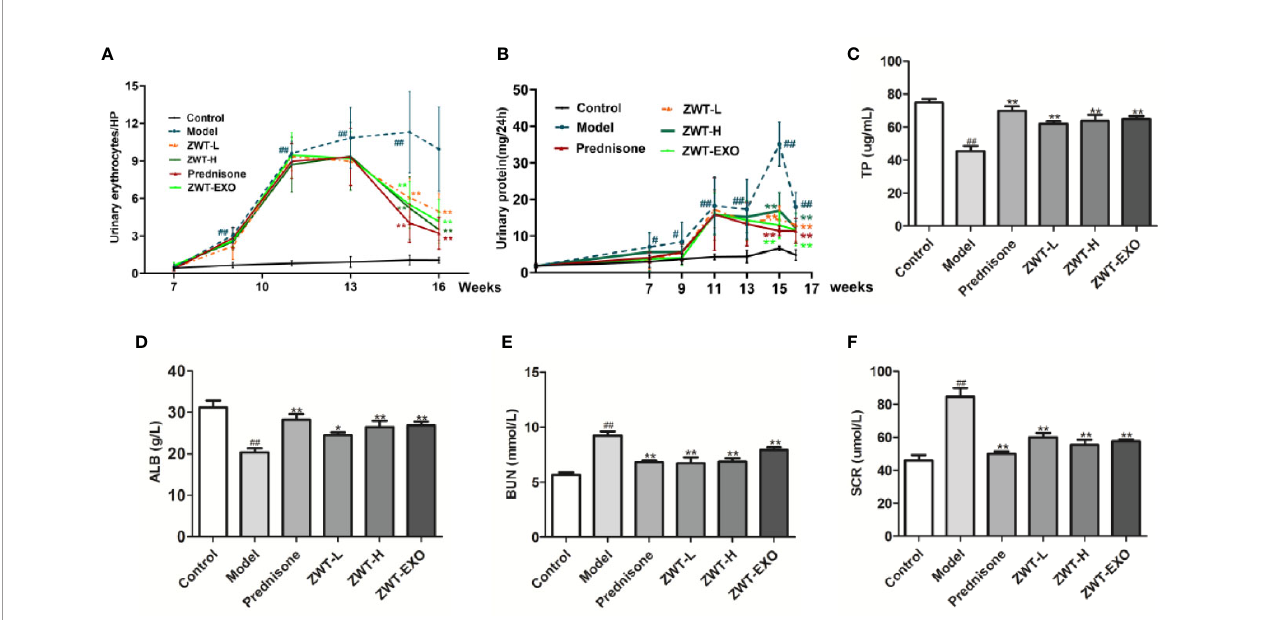
FIGURE 6 | ZWT-EXO improved renal function of immunoglobulin A nephropathy (IgAN) rats. (A) 24-h urine protein of the IgAN rats in the different periods. (n = 8). (B) Urinary erythrocyte numbers at high power fi eld of the IgAN rats in the different periods. (n = 8). (C – F) The content of total protein (TP), albumin (ALB), blood urea nitrogen (BUN), and serum creatinine (SCR) in the serum of IgAN rats (n= 5). All values were presented as mean ± SD. # P < 0.05, ## P < 0.01, compared with control group; *P < 0.05, **P < 0.01, compared with lipopolysaccharide (LPS) group.